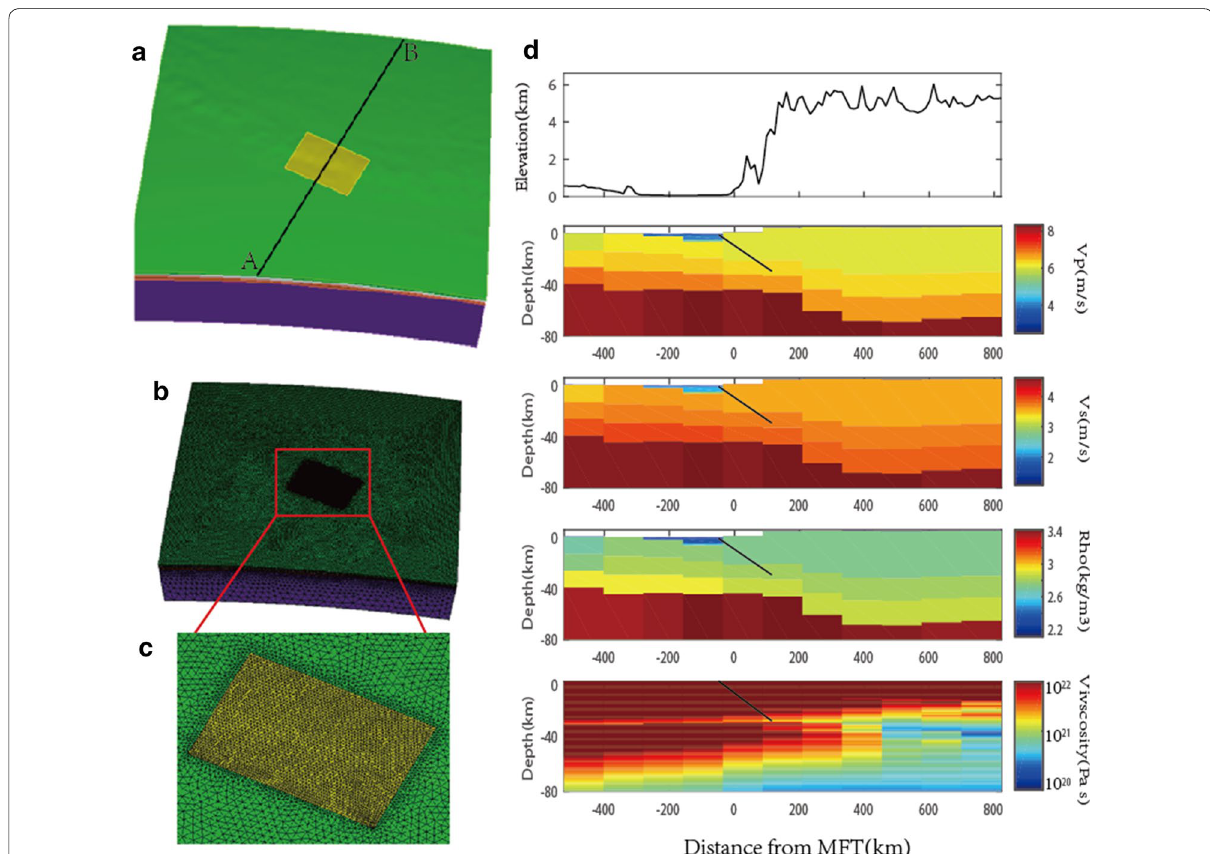
Fig. 3 FEM structure used in the numerical simulation. a The yellow rectangle denotes fault rupture. The top surface exhibits topographical relief. The color blocks denote the upper, middle and lower crust and the mantle, respectively. The profile AB is normal to the MFT. b Map view of the FEM mesh. c The larger view of the FEM mesh in the near-field area of the Gorkha earthquake. d The elevation, Vp, Vs, density and viscosity variations along the profile AB. The black line is the source rupture